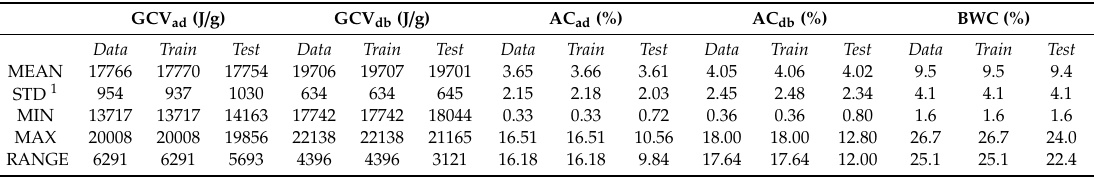
Table 1. Descriptive statistics results of gross calorific value (GCV), ash content (AC) and bound